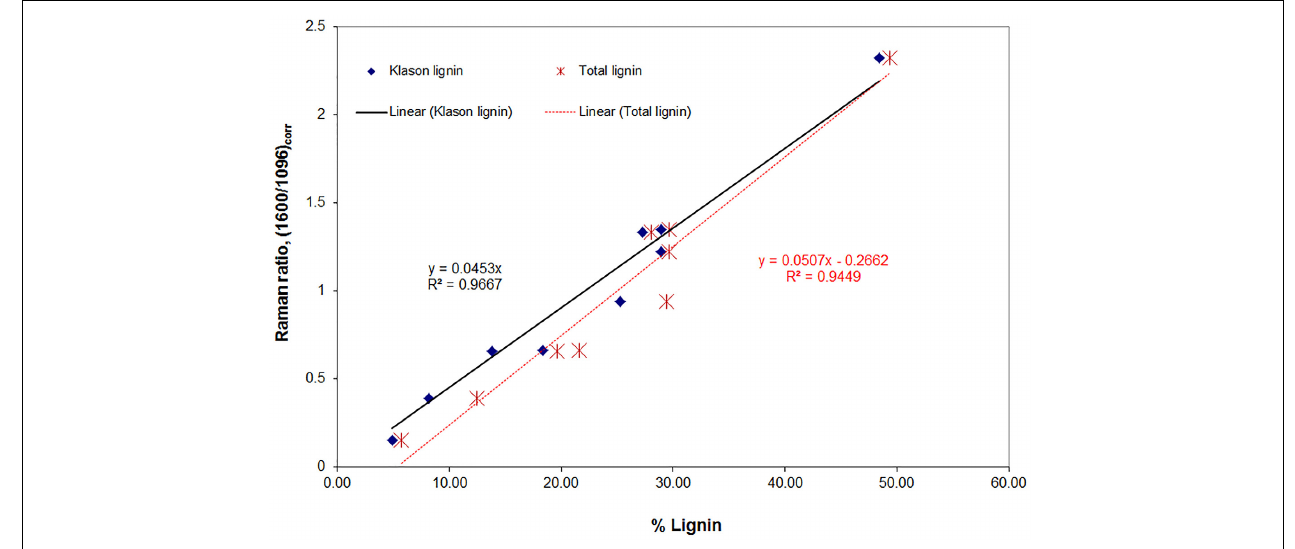
FIGURE 5 | Correlations of lignin’s 1600cm − 1 band intensity with Klason and total lignin for various lignocellulosic materials. Klason lignin (%) is listed in parentheses. Black spruce MWEL (48.4), 2 samples